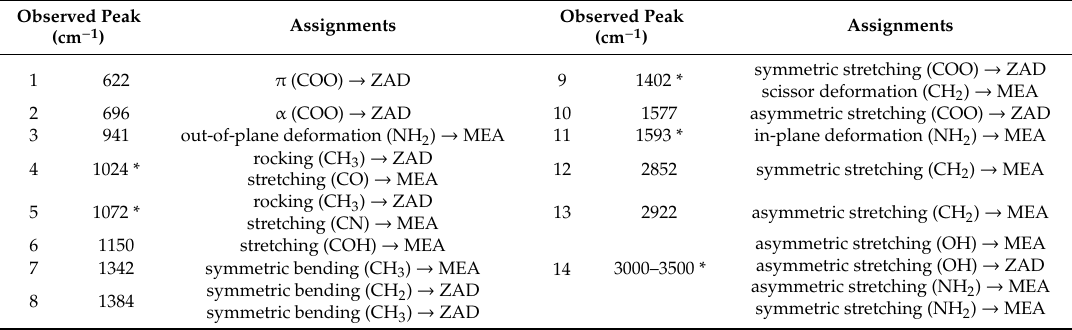
Table 2. Wavenumbers of distinct absorption peaks in the IR spectrum of as-prepared gel, numbered as one to 14 in Figure 3. The molecular bonds and vibration modes of constituent peaks are